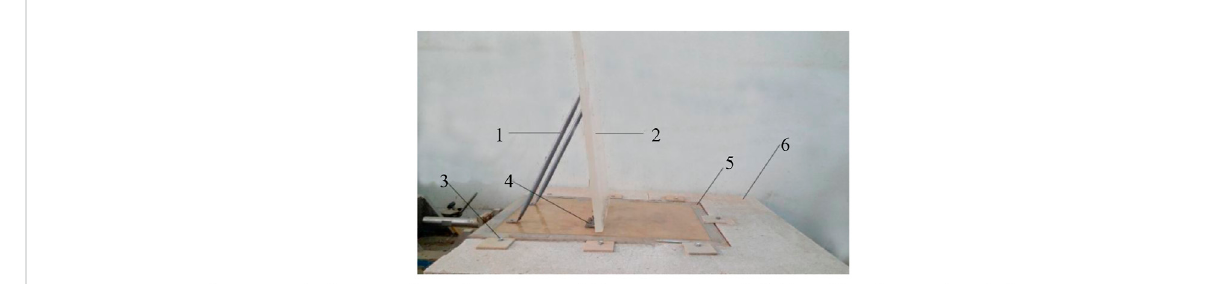
FIGURE 4 Model frame of the shaking table.